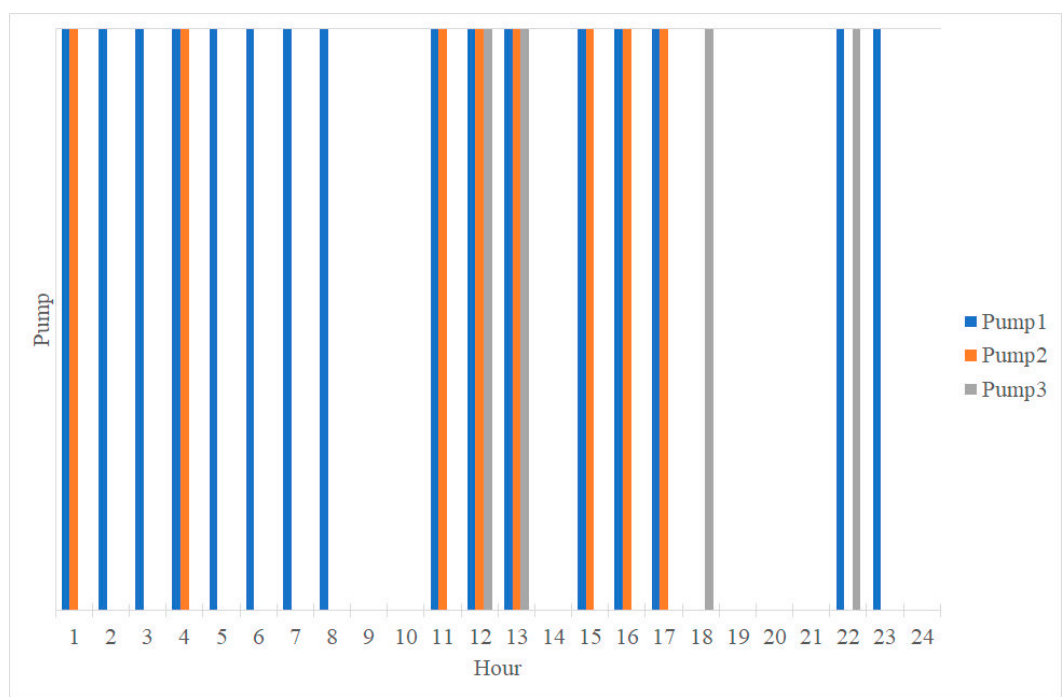
Figure 5. Optimal ON/OFF sequence of Anytown Modified (ATM) network (Cimorelli et al., 2020).